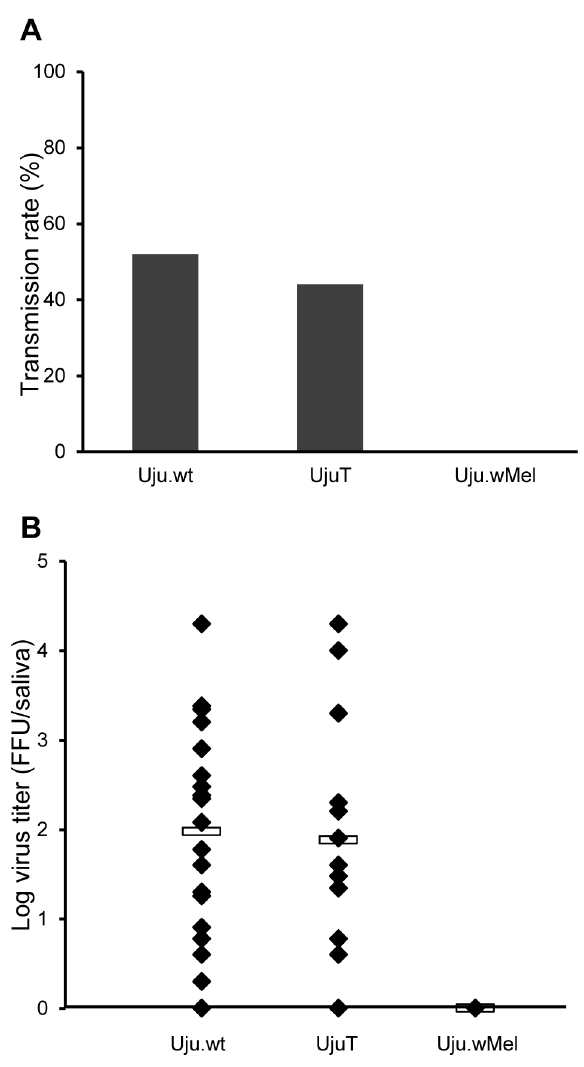
Figure 4. CHIKV challenge. Mosquitoes were allowed to feed on artificial blood meals containing virus suspension and 7 days post infection 35–50 females were used for forced salivation. Samples were titrated by focus fluorescent assay on Ae. albopictus C6/36 cells. The transmission rate was estimated as the percentage of mosquitoes with infectious saliva among tested mosquitoes (A). Saliva samples were titrated by focus fluorescent assay on C6/36 Ae. albopictus cell culture. The total number of plaques was counted and the titer was calculated as FFU/saliva (B). No significant difference was found between Uju.wt and UjuT viral titers using a Wilcoxon rank sum